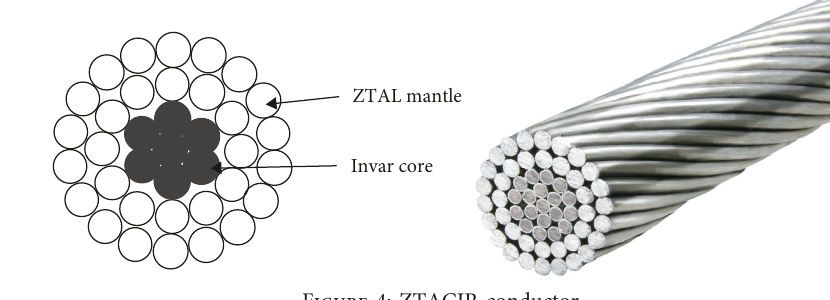
Figure 4: ZTACIR conductor.